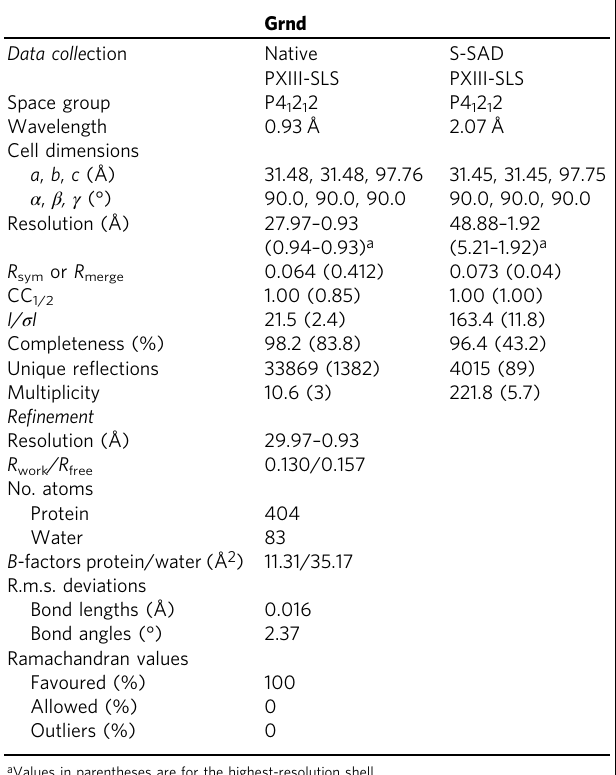
Table 1 Data collection and re fi nement statistics of the Grnd